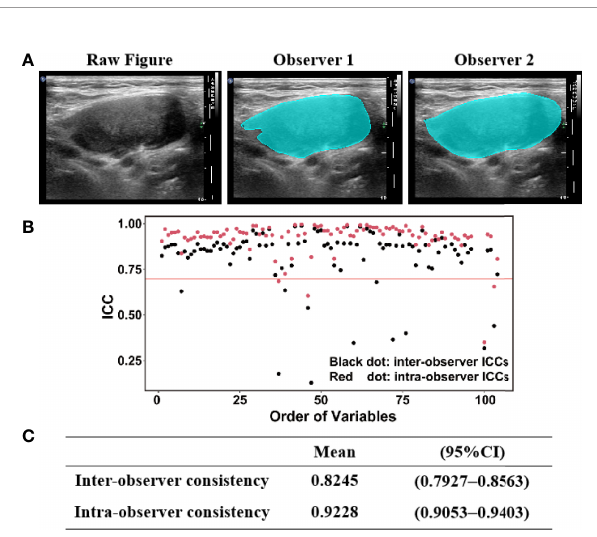
FIGURE 3 | (A) ROI (region of interest) was delineated according to the lymph node boundary by two radiologists. (B,C) Intraclass correlation coef fi cient (ICC) scores for inter- observer and intra-observer measurements